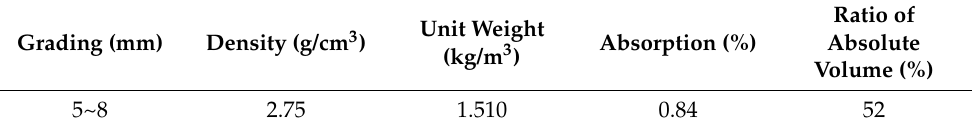
Table 4. Physical properties of aggregate.